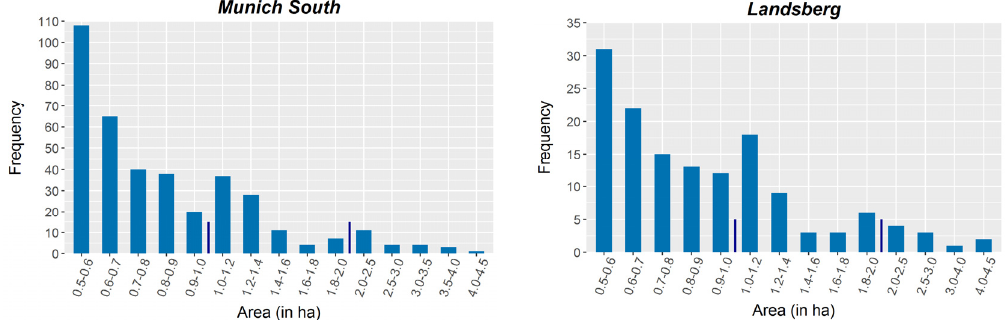
Figure 9. Frequency of size distribution of windthrow affected areas ≥ 0.5 ha for Munich South ( Left ) and Landsberg ( Right ) resulting from the object ‐ based approach.